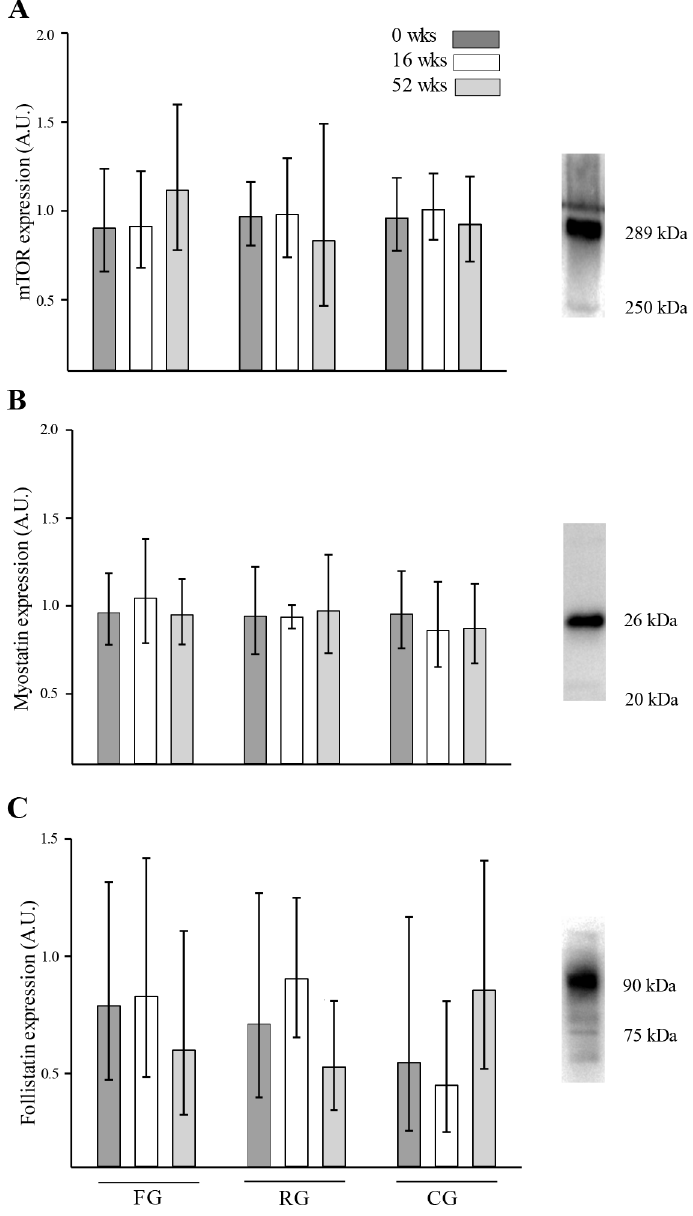
Fig 4. Protein expression in muscle homogenate lysates. Expression (A.U.: arbitrary units) of (A) mammalian target of rapamycin (mTOR), (B) myostatin, and (C) in elderly subjects after 0 (dark bars), 16 (white bars) or 52 wks (grey bars) of soccer training (SG), resistance training (RG) and continuation of an inactive lifestyle (CG). Geometric means and 95% confidence interval are presented.